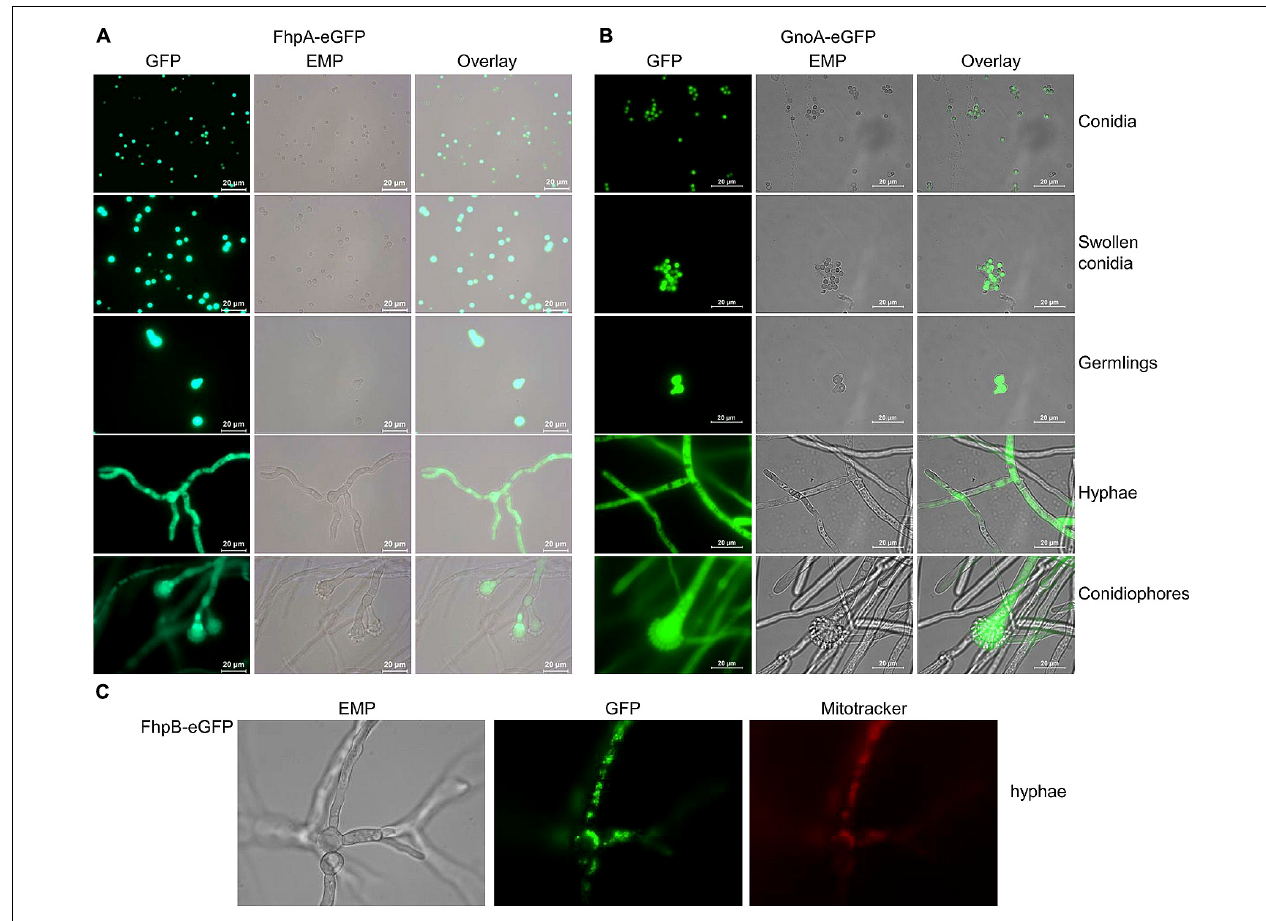
FIGURE 4 | Localization of FhpA-eGFP, GnoA-eGFP, and FhpB-eGFP using fluorescence microscopy. (A) Fluorescence of strains FhpA-eGFP and (B) GnoA-eGFP was monitored in resting conidia (stored in H 2 O), in swollen conidia (incubation for 3 h in AMM),